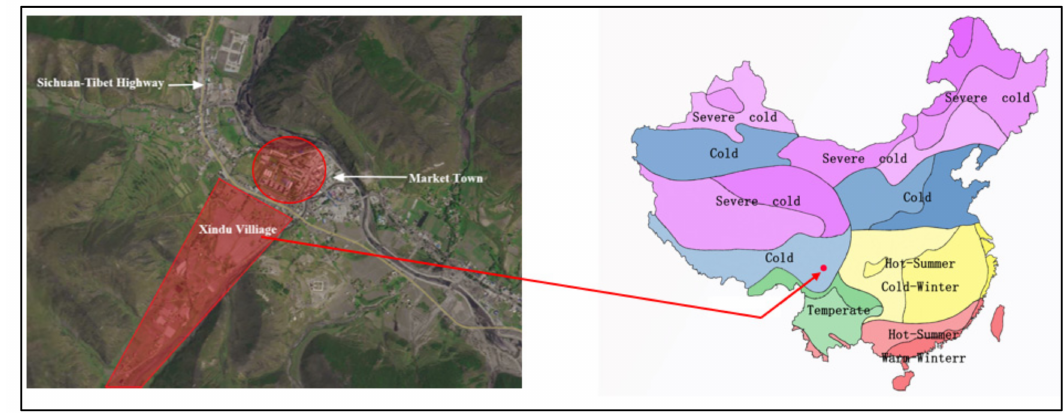
Figure 1. Chinese architectural design zoning and the location of experimental objects.